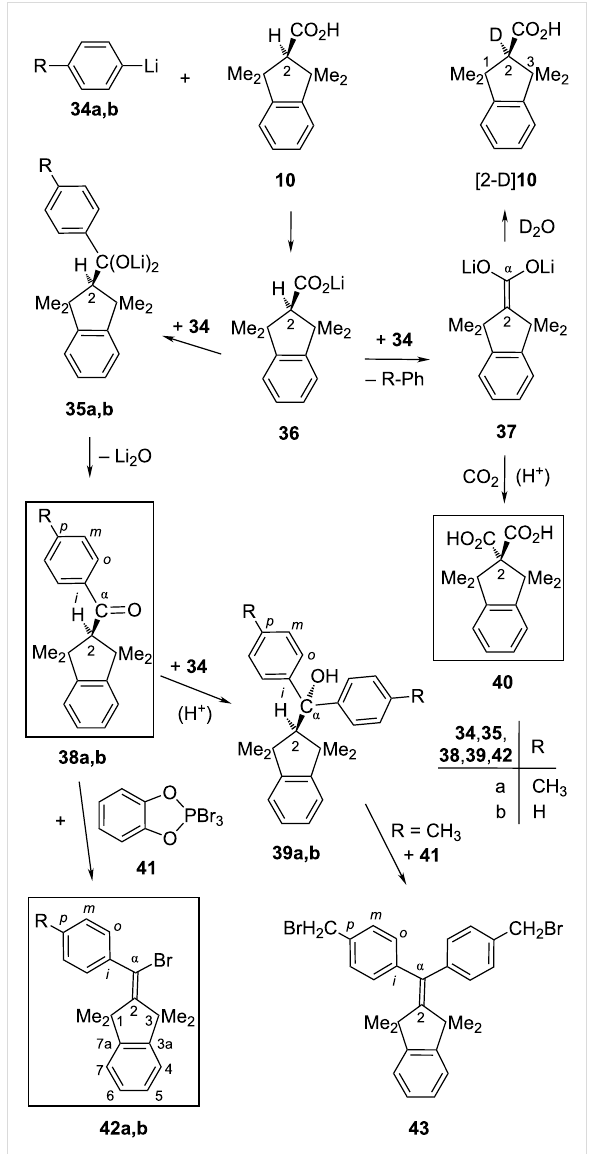
Scheme 6: Synthesis of the one-sidedly overcrowded descendants 38 , 39 , and 42